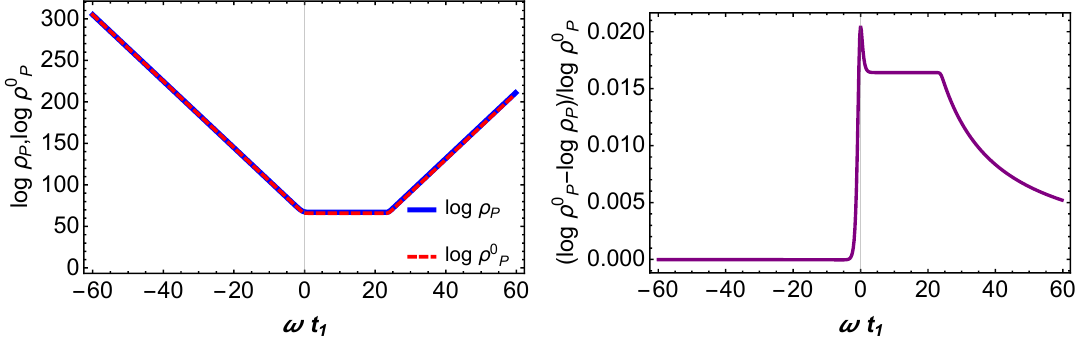
− log ρ ) / log ρ 0 P P P